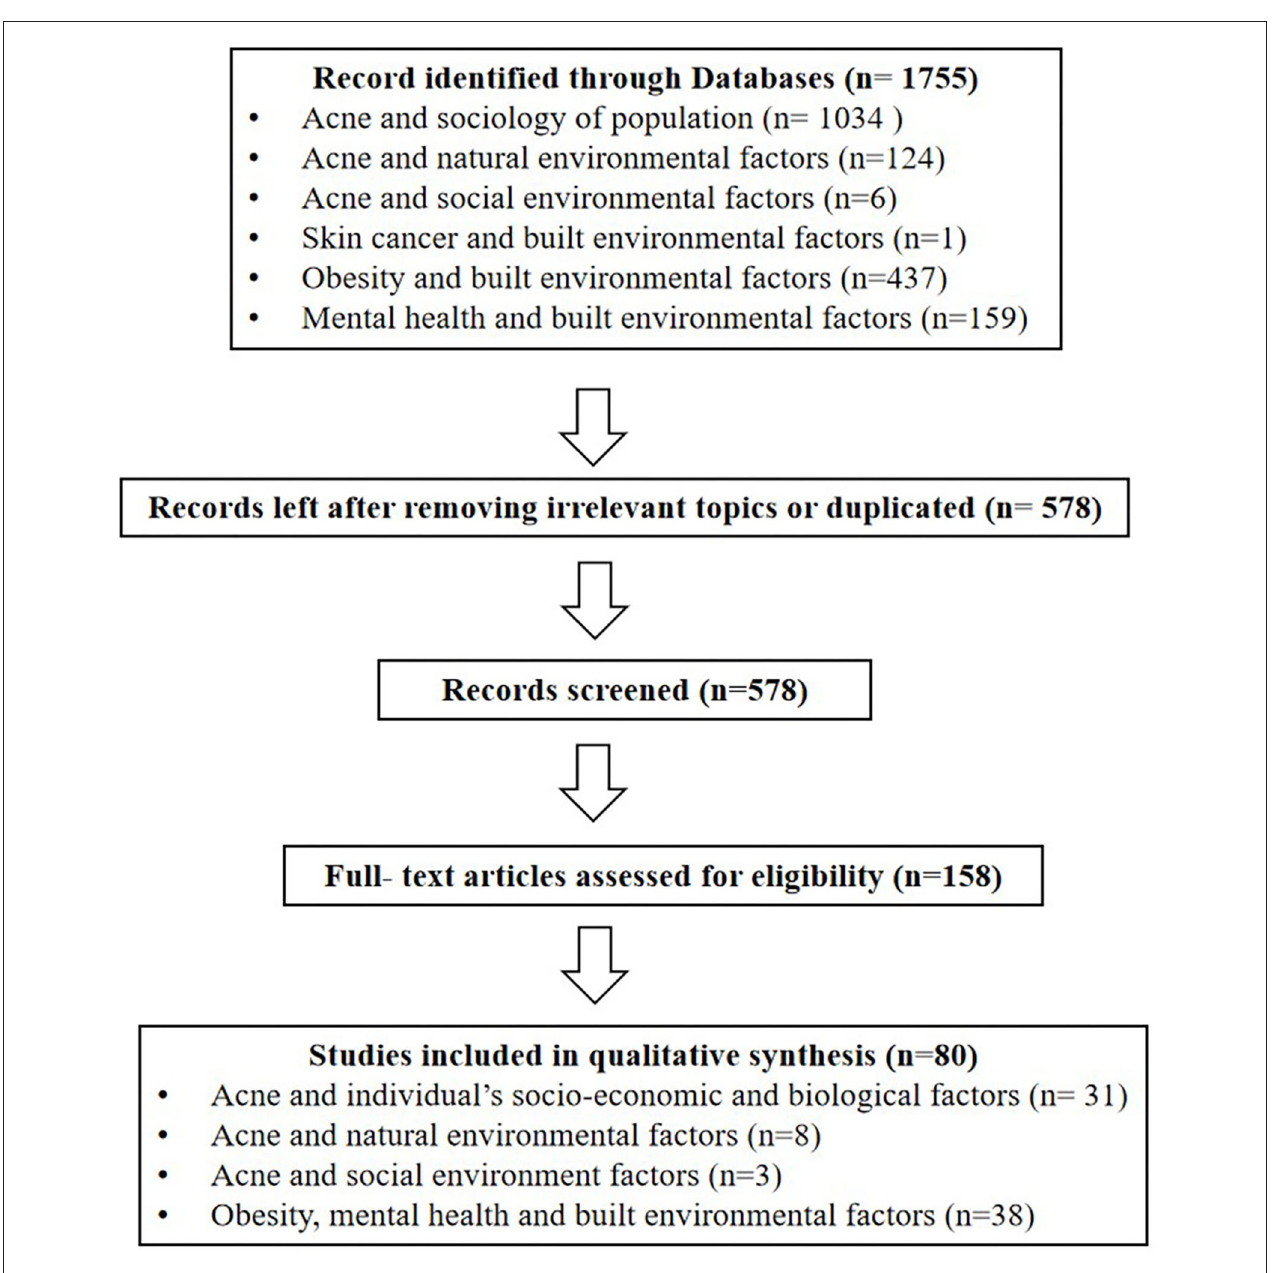
FIGURE 1 | Illustrates the study inclusion and exclusion process.